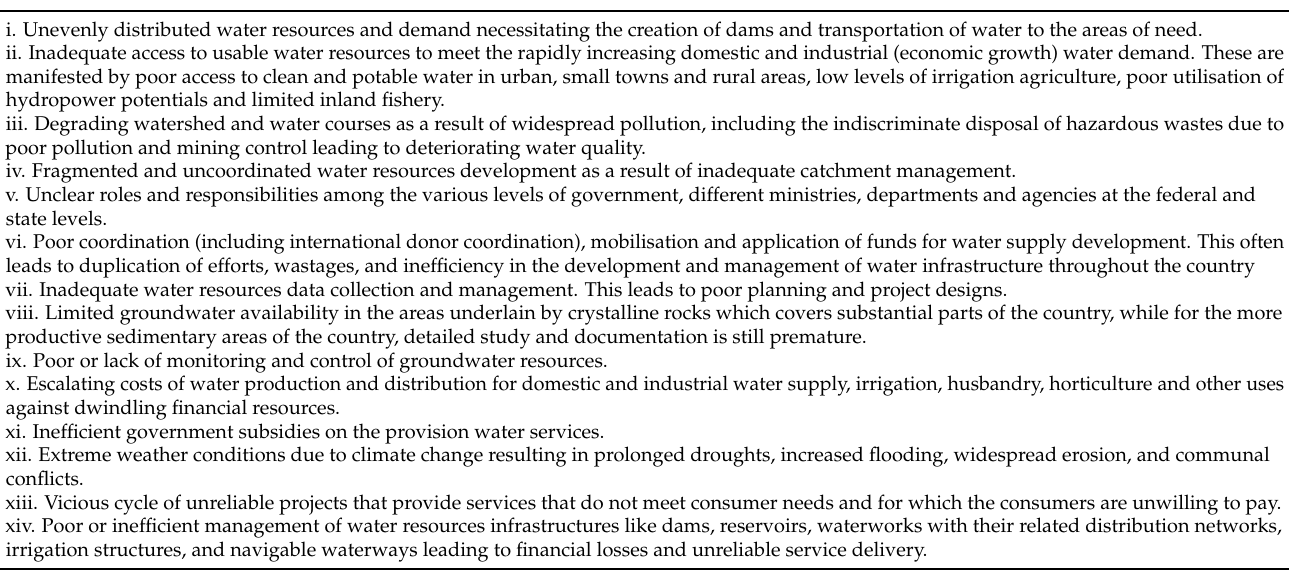
Table A1. Current challenges in water resource management